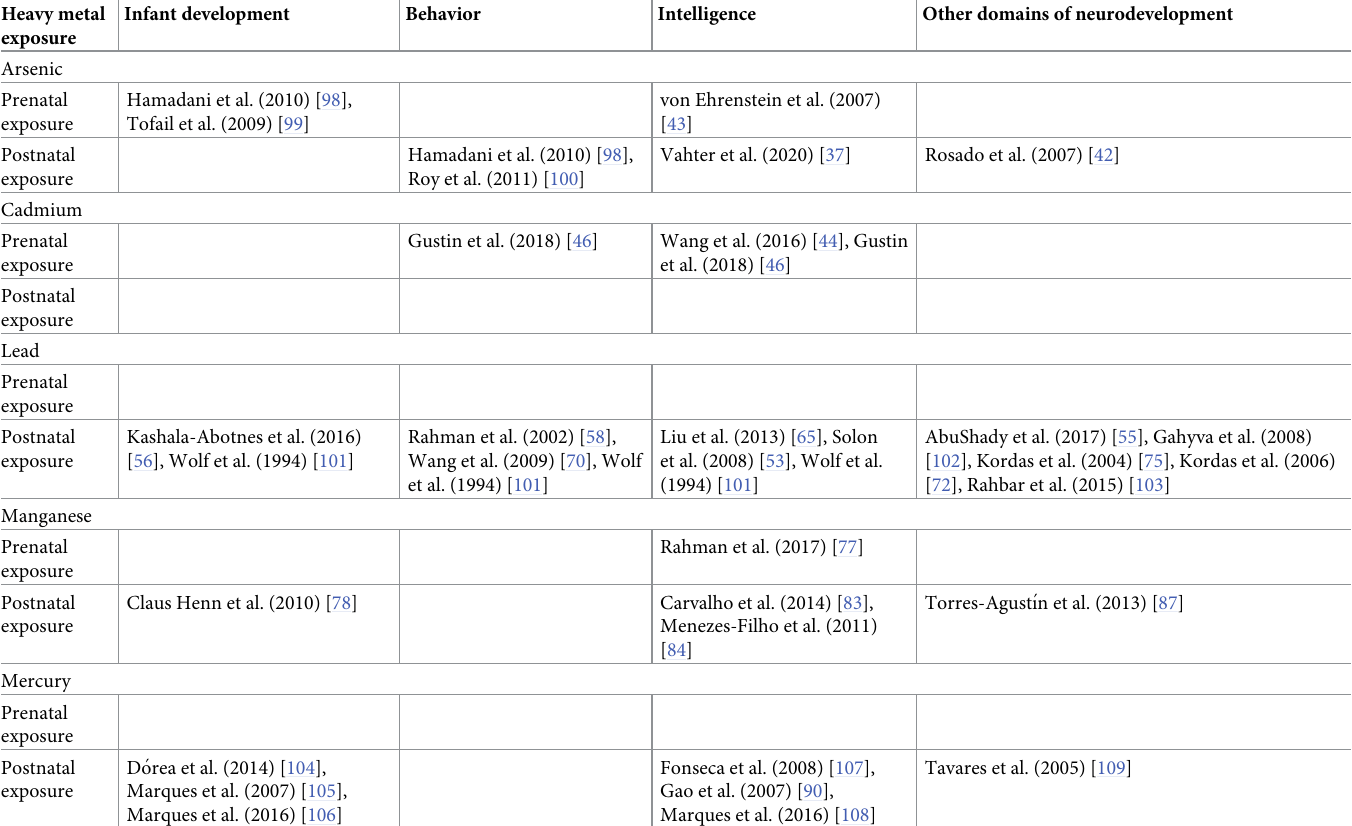
Table 2. Studies that found no association between heavy metal exposure and various domains of